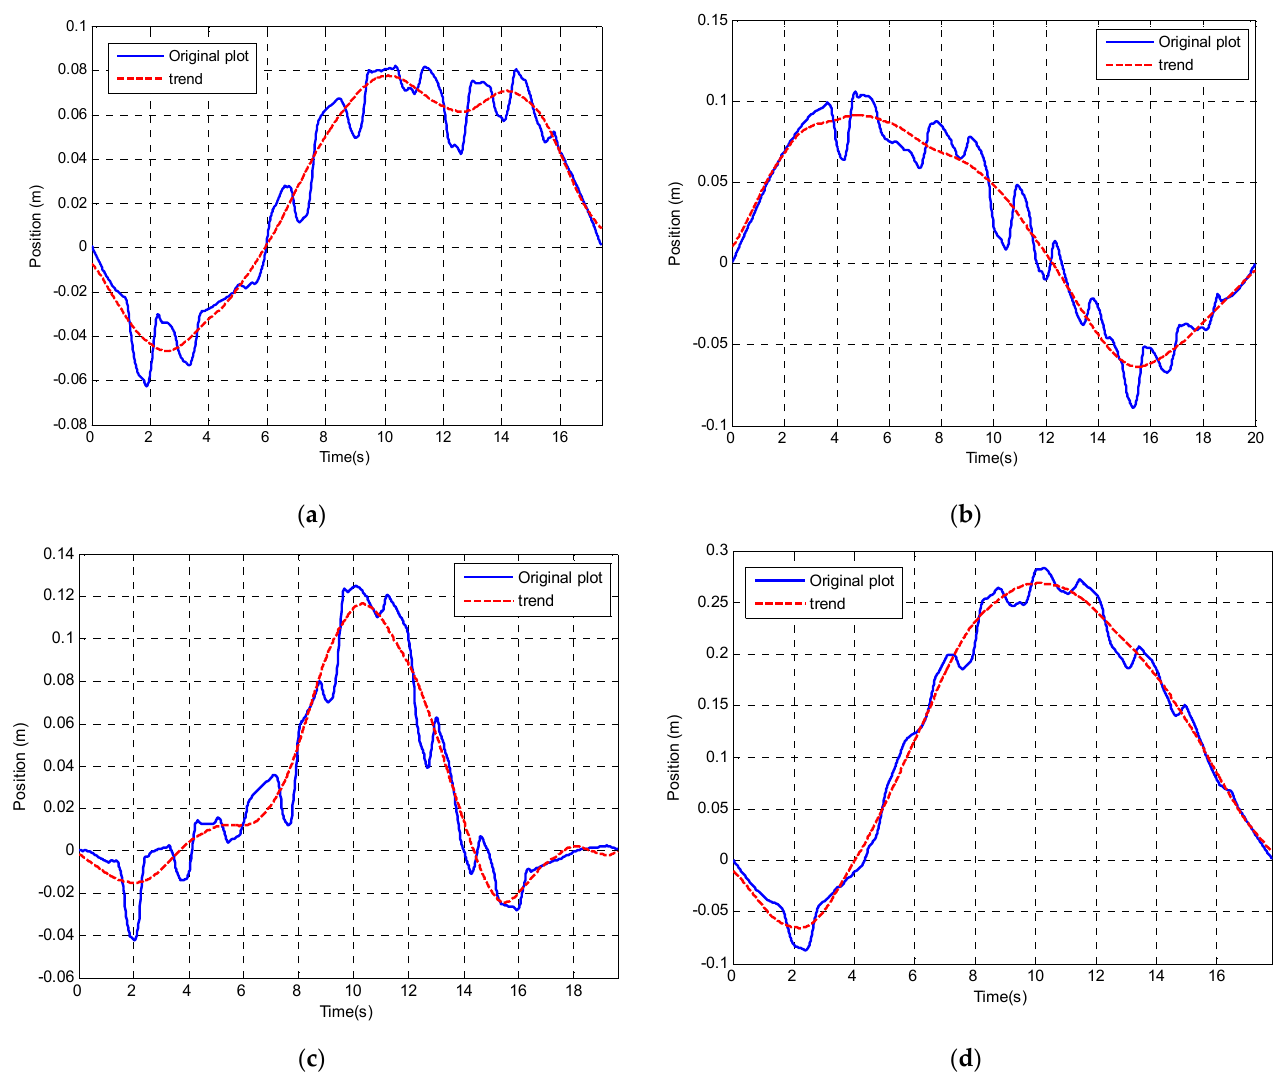
Figure 11. Low frequency offset variation after double integration (red plot is the low frequency trend). ( a ) Experiment Test 1. ( b ) Experiment Test 2. ( c ) Experiment Test 3. ( d ) Experiment Test 4.